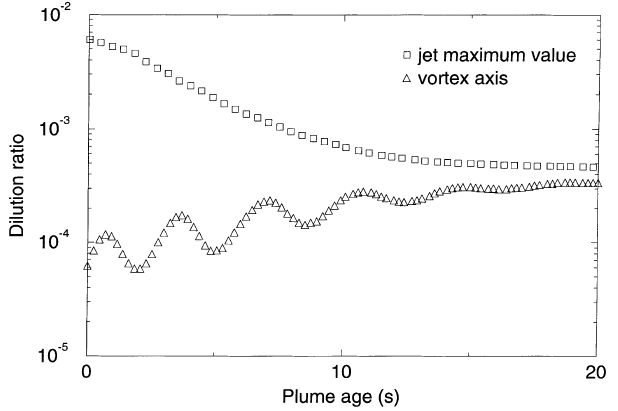
Fig. 8. Dilution ratio profiles calculated at di(cid:128)erent locations inside the wake vortex of a twin-engine A-330. These results are computed from a direct numerical simulation of a convection-di(cid:128)usion equation. The squares denote the maximum of tracer concentration. The triangles represent the computation of the dilution ratio on the